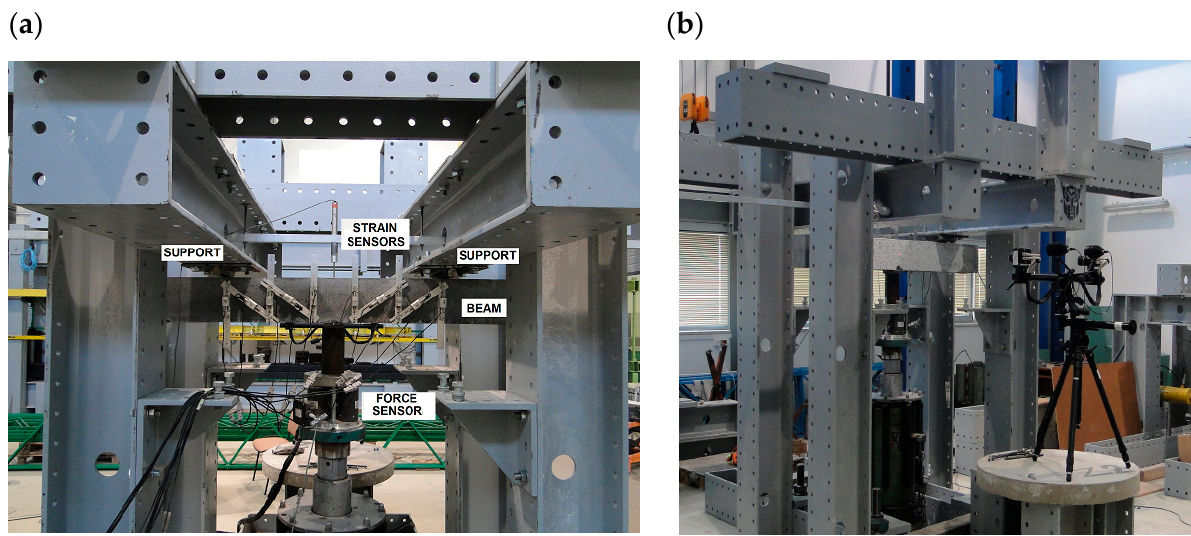
Figure 6. Schematic of experimental setup [44].